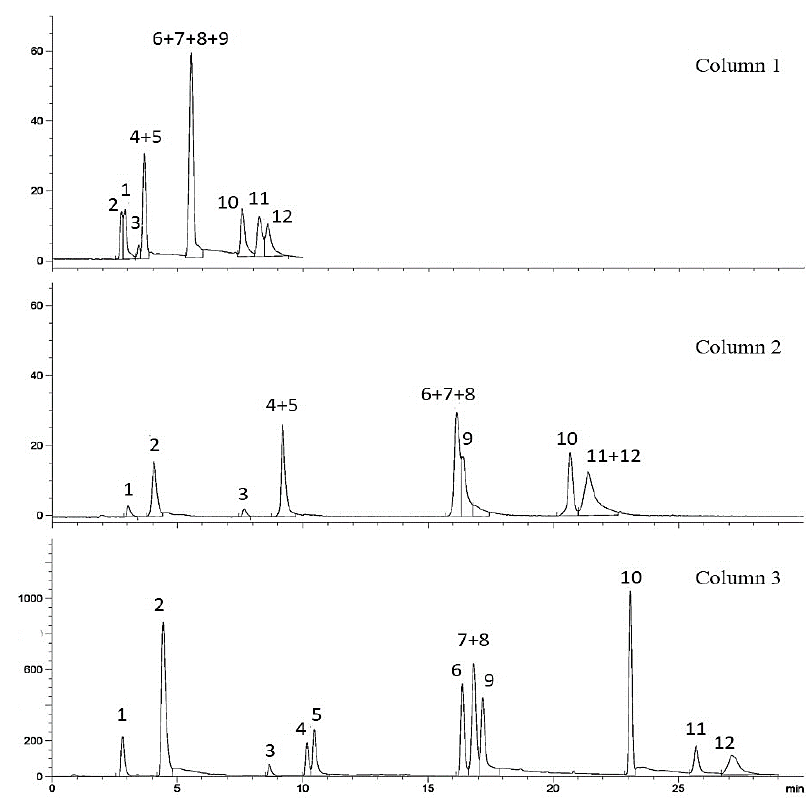
Figure 2. Comparison of chromatograms obtained on columns, 1 , 2 , and 3 .